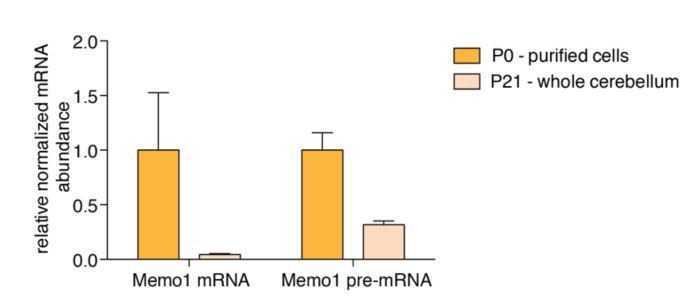
Memo1 mature mRNA and pre-mRNA expression.RT-qPCR data showing relative abundance of Memo1 mature mRNA and pre-mRNA in purified granule cells from P0 cerebella and whole P21 cerebella.N=3, Error bars: SEM. Memo1 mRNA and pre-mRNA fold changes between the two conditions (P0 and P21) are 23.8 and 3.2 fold, respectively. P-value for difference in log2(FC P0/P21) = 0.0292.